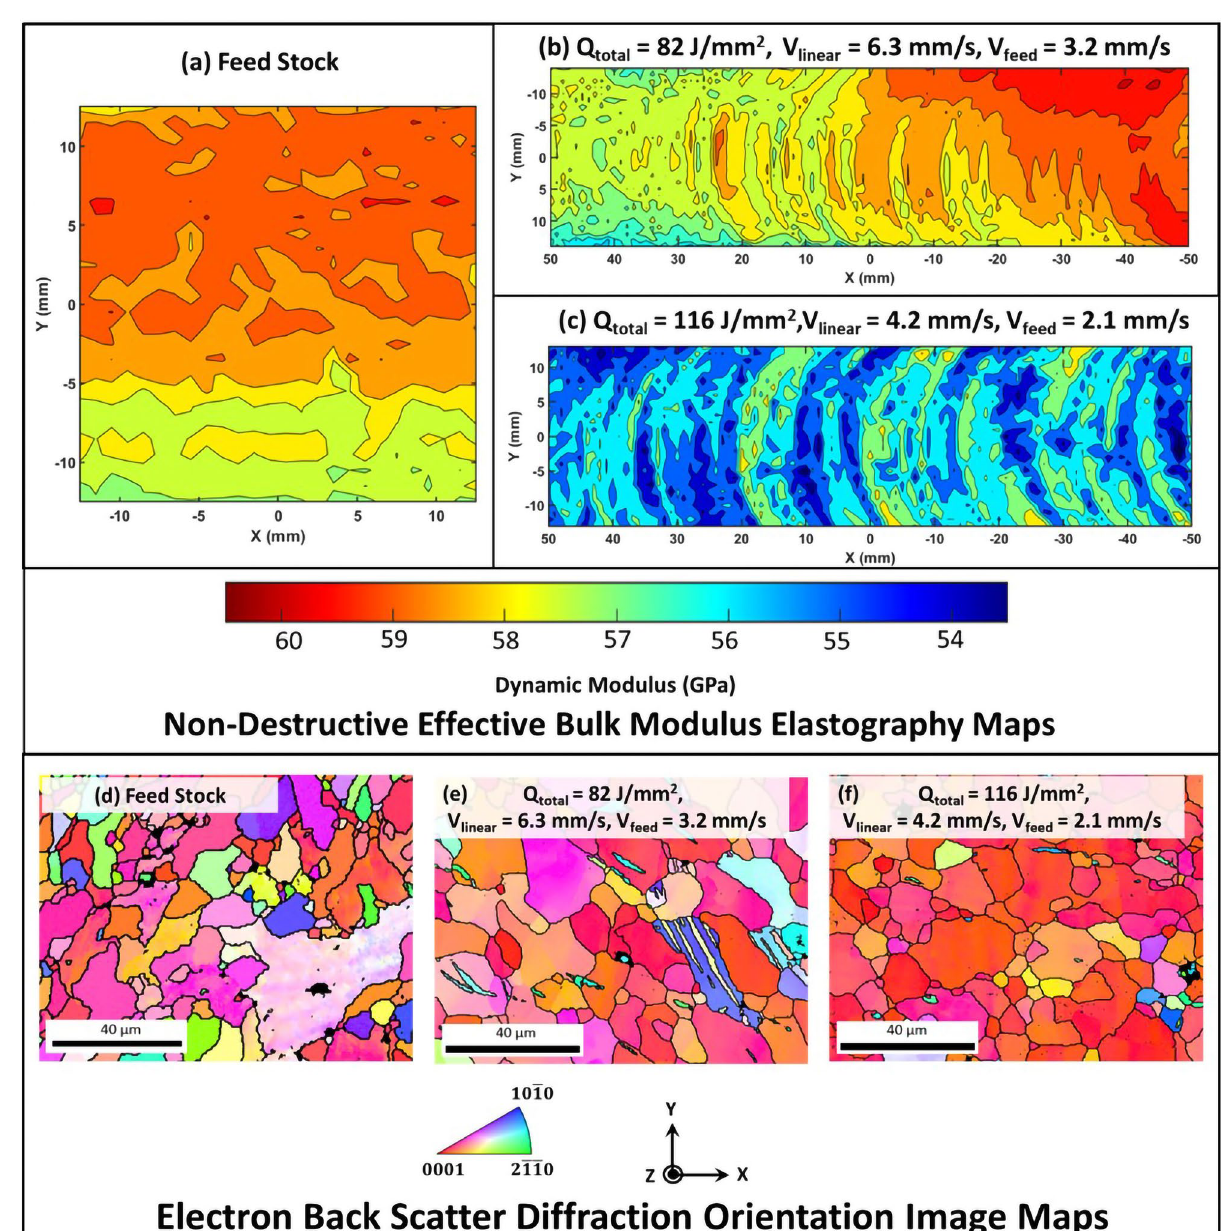
2 , and 2 , and ( f ) 116 J/